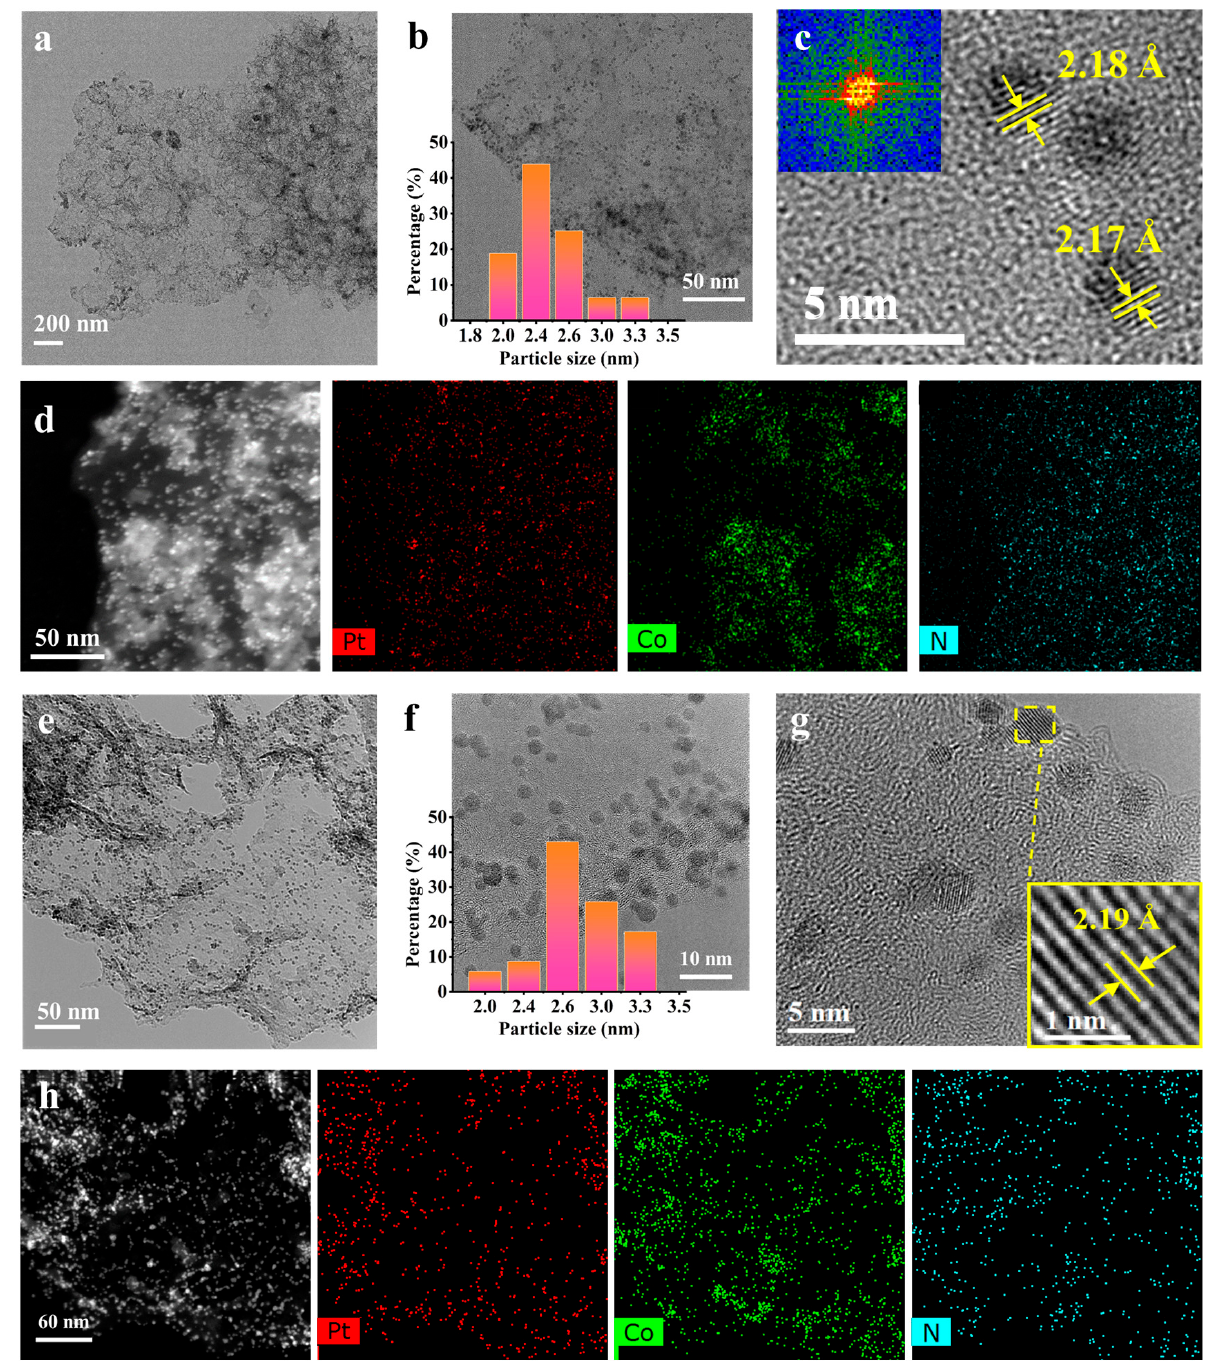
Figure 8. TEM images of PtCo 3 -ba ( a , b ), PtCo 3 -su ( e , f ). HRTEM of PtCo 3 -ba ( c ), PtCo 3 -su ( g ). Elemental mappings of PtCo 3 -ba ( d ), PtCo 3 -su ( h ).